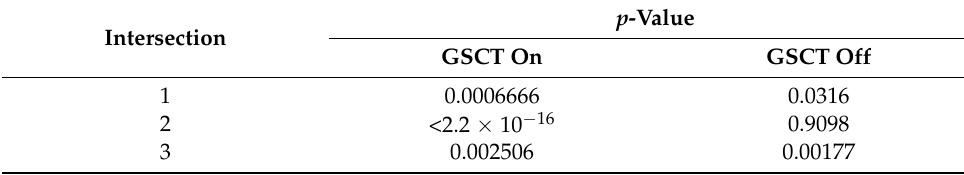
Table 3. Pearson test of compliance of travel times after the green signal. Intersection